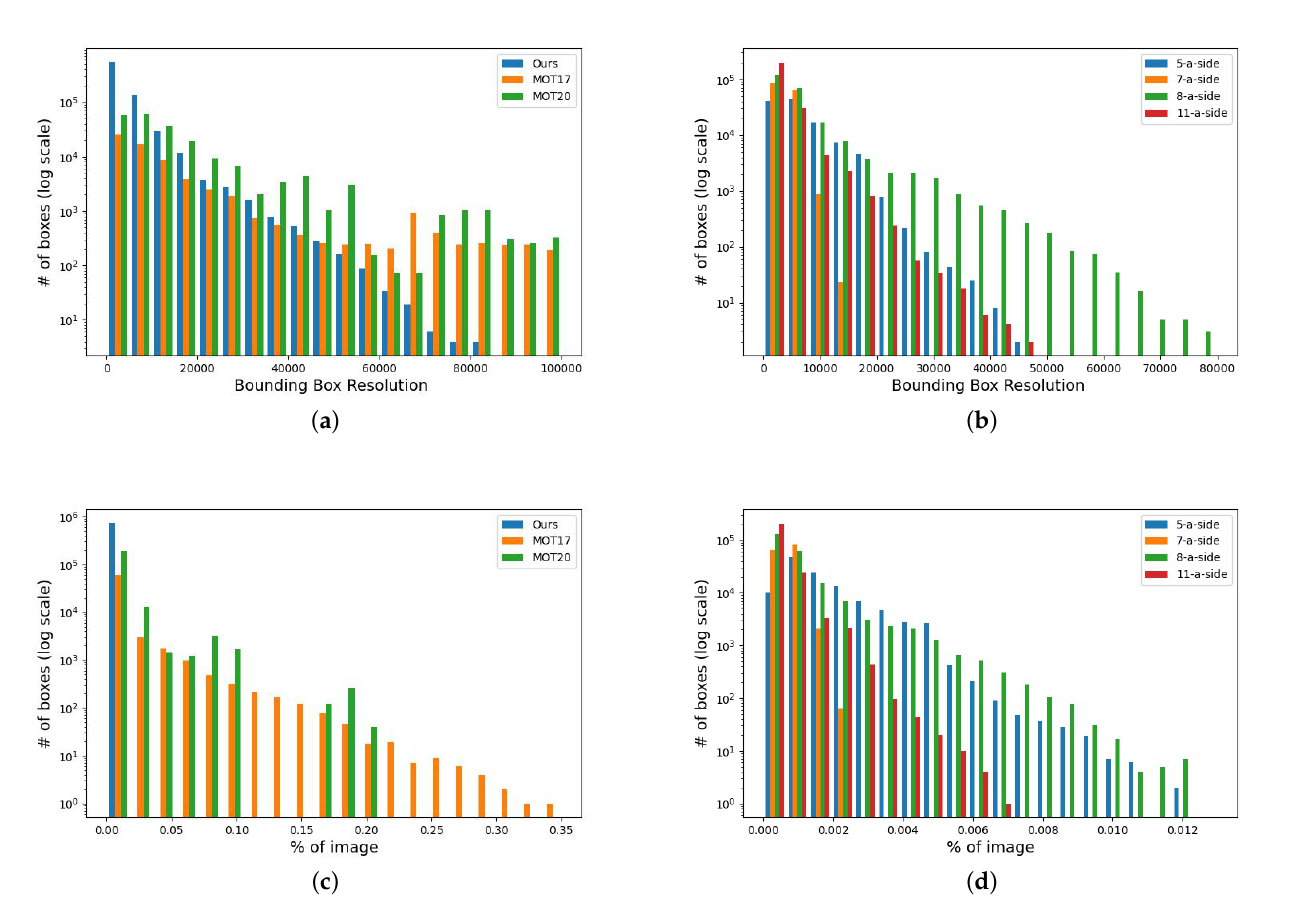
Figure 6. Bounding-box resolution (related to total number of pixels in box) distribution ( a , b ) and bounding-box image proportion (related to box occupation percentage of the image) distribution ( c , d ). ( a ) Comparison between our dataset and MOTChallenge dataset. ( b ) Comparison between subdatasets of our dataset. ( c ) Comparison between our dataset and MOTChallenge dataset. ( d ) Com- parison between subdatasets of our